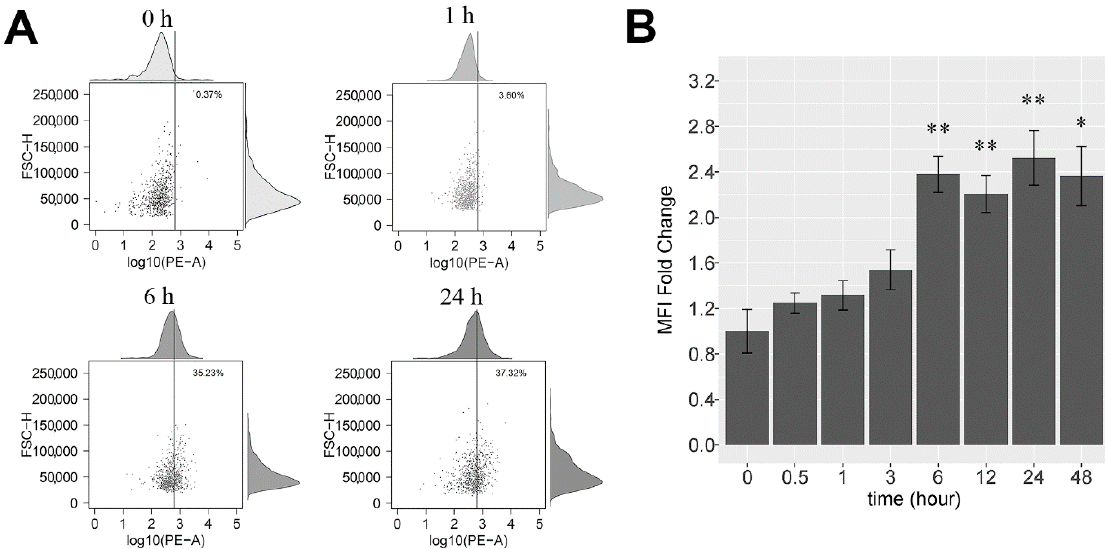
Figure 5. Measurement of NDMV uptake by flow cytometry: ( A ) portrays scatter plot of untreated, control FLS, and 1 h, 6 h and 24 h after addition of NDMVs at a ratio of 100. The vertical line is the gating threshold to identify NDMV-negative and -positive FLS. The upper and right panels are density curves of target fluorescence in FLS and cell size. ( B ) The mean MFI fold change over time of incubation of FLS with labeled NDMVs. Data were normalized to FLS in the absence of NDMVs. Each point represents the mean (±SE) from 5 independent experiments. Significant differences between groups were identified using the Kruskal–Wallis test followed by the Conover–Inman test. * p < 0.05, ** p < 0.01.